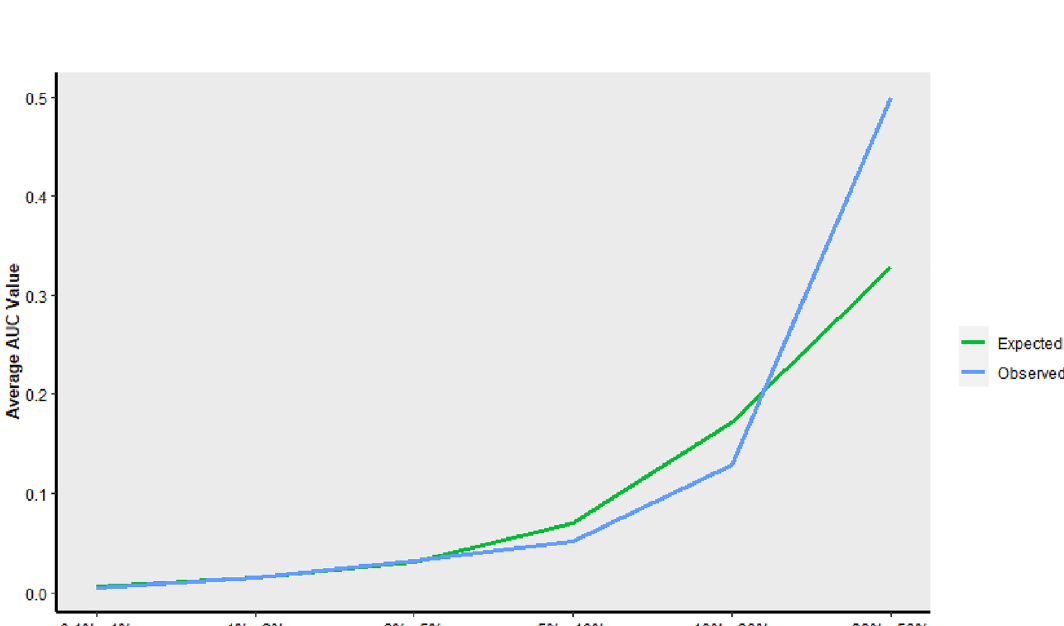
Figure 3. Predicted probability of venous thromboembolism (pulmonary embolus or deep vein thrombosis) and observed proportion stratified into groups based on